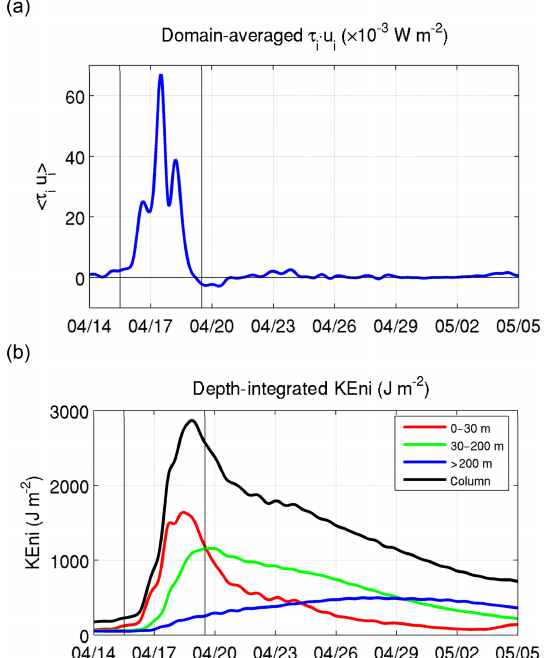
Figure 7. Time series of (a) the area-averaged wind energy flux into the near-inertial band (unit: 10 − 3 Wm − 2 ) and (b) depth-integrated KEni (Jm − 2 ) in the forced region for different